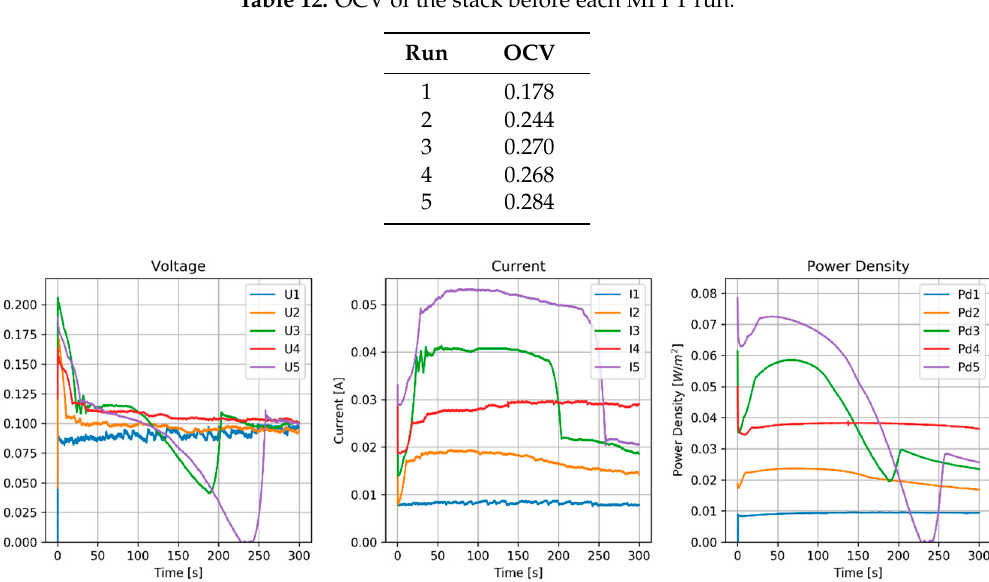
Figure 13. Results of MPPT test of the RED stack equipped with pseudo AEMs (Ag/AgCl) and pseudo CEMs (Zn). Flow rate (H and L) is 60 mL/min.